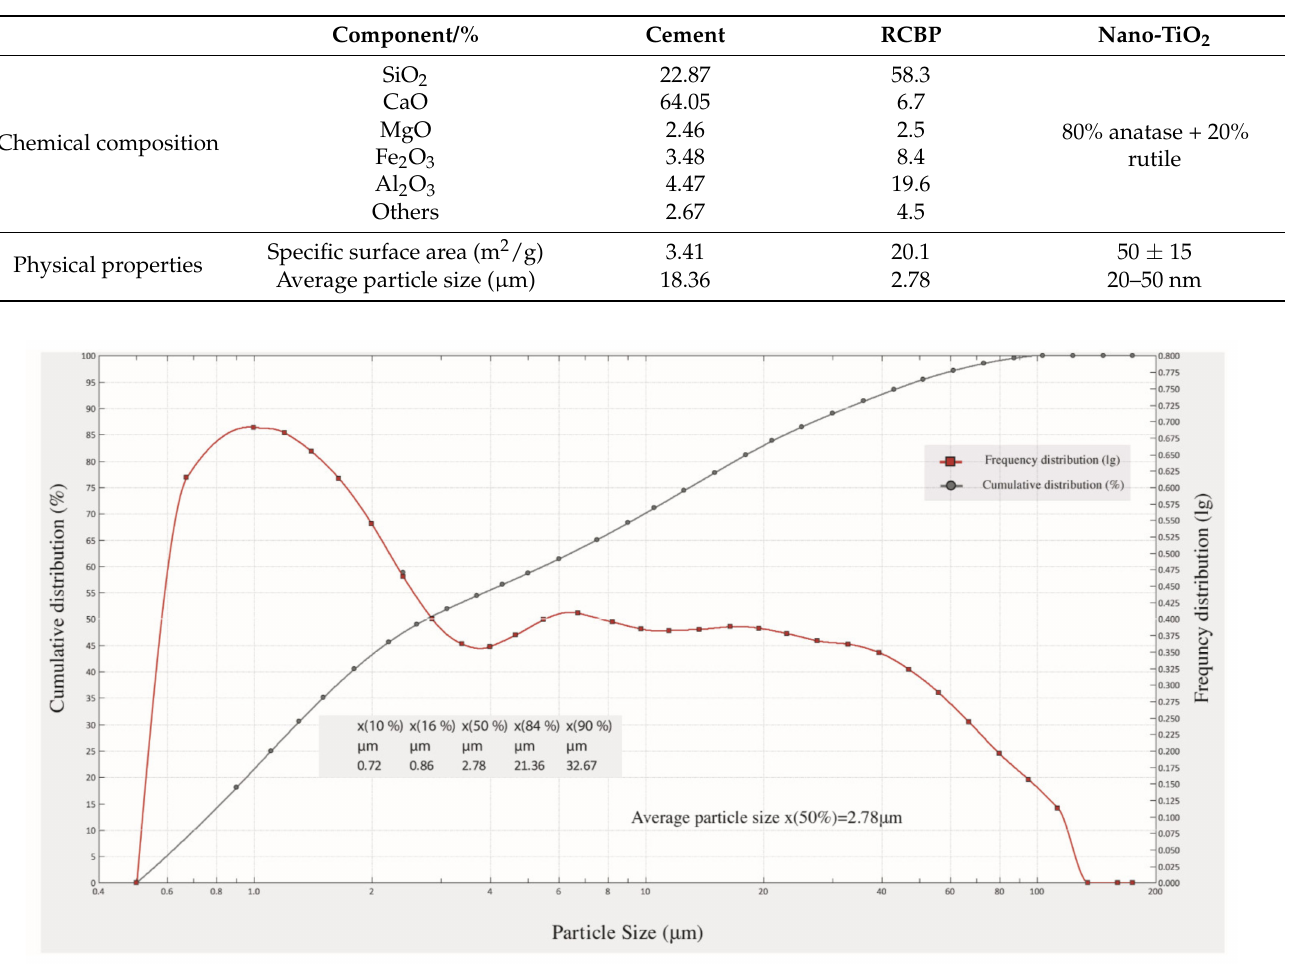
Table 1. Chemical composition and physical properties of raw materials (Cement and RCBP).